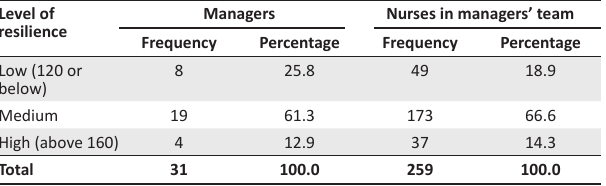
TABLE 3: Summary of managers and nurse respondents in the managers’ team, categorised by level of resilience of the manager. Level of resilience